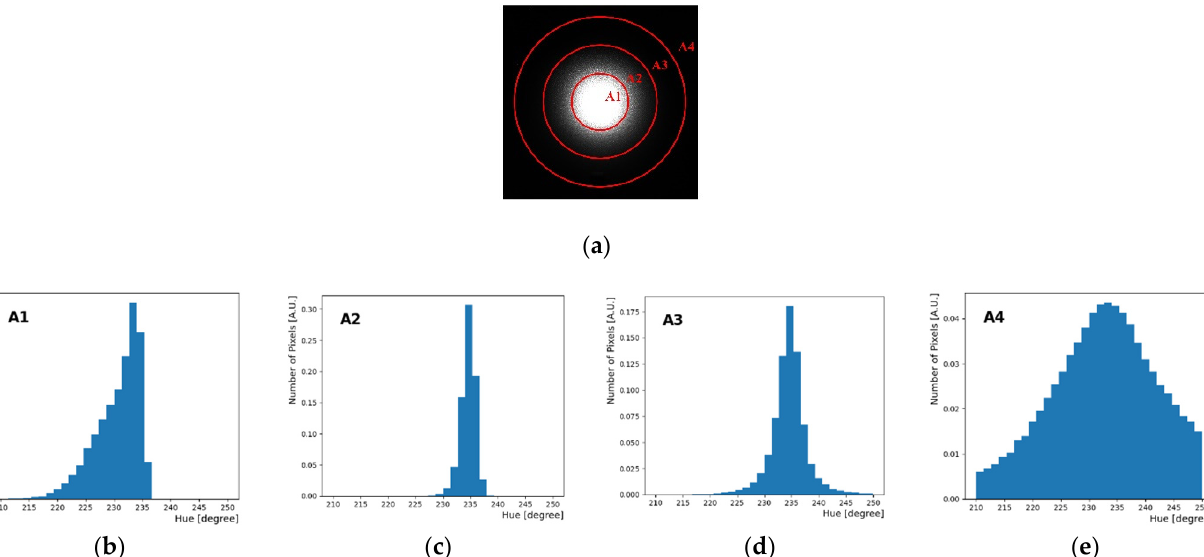
Figure 5. H distribution according to each area when using 440 nm laser source. ( a ) Raw image is divided into four circular areas (A1, A2, A3, A4). ( b ) H distribution of the innermost area 1. ( c ) Area 2. ( d ) Area 3. ( e ) The outermost area A4. The H peak positions are not significantly different (230.54, 234.55, 234.56, 235); however, the shape or resolution of the H distribution depends on the selected region.